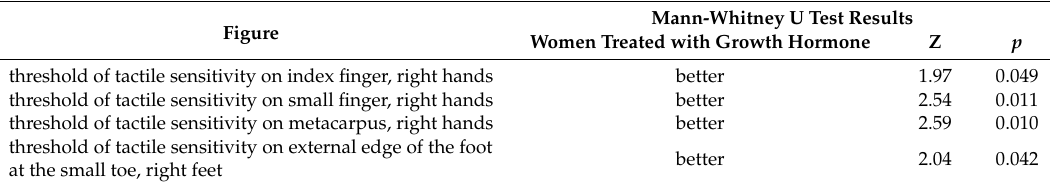
Table 4. Statistically significant di ff erences in tactile sensitivity among women with Turner syndrome treated and untreated with growth hormone. Mann-Whitney U Test Results Figure Women Treated with Growth Hormone Z p threshold of tactile sensitivity on index finger, right hands better 1.97 0.049 threshold of tactile sensitivity on small finger, right hands better 2.54 0.011 threshold of tactile sensitivity on metacarpus, right hands better 2.59 0.010 threshold of tactile sensitivity on external edge of the foot better 2.04 0.042 at the small toe, right feet